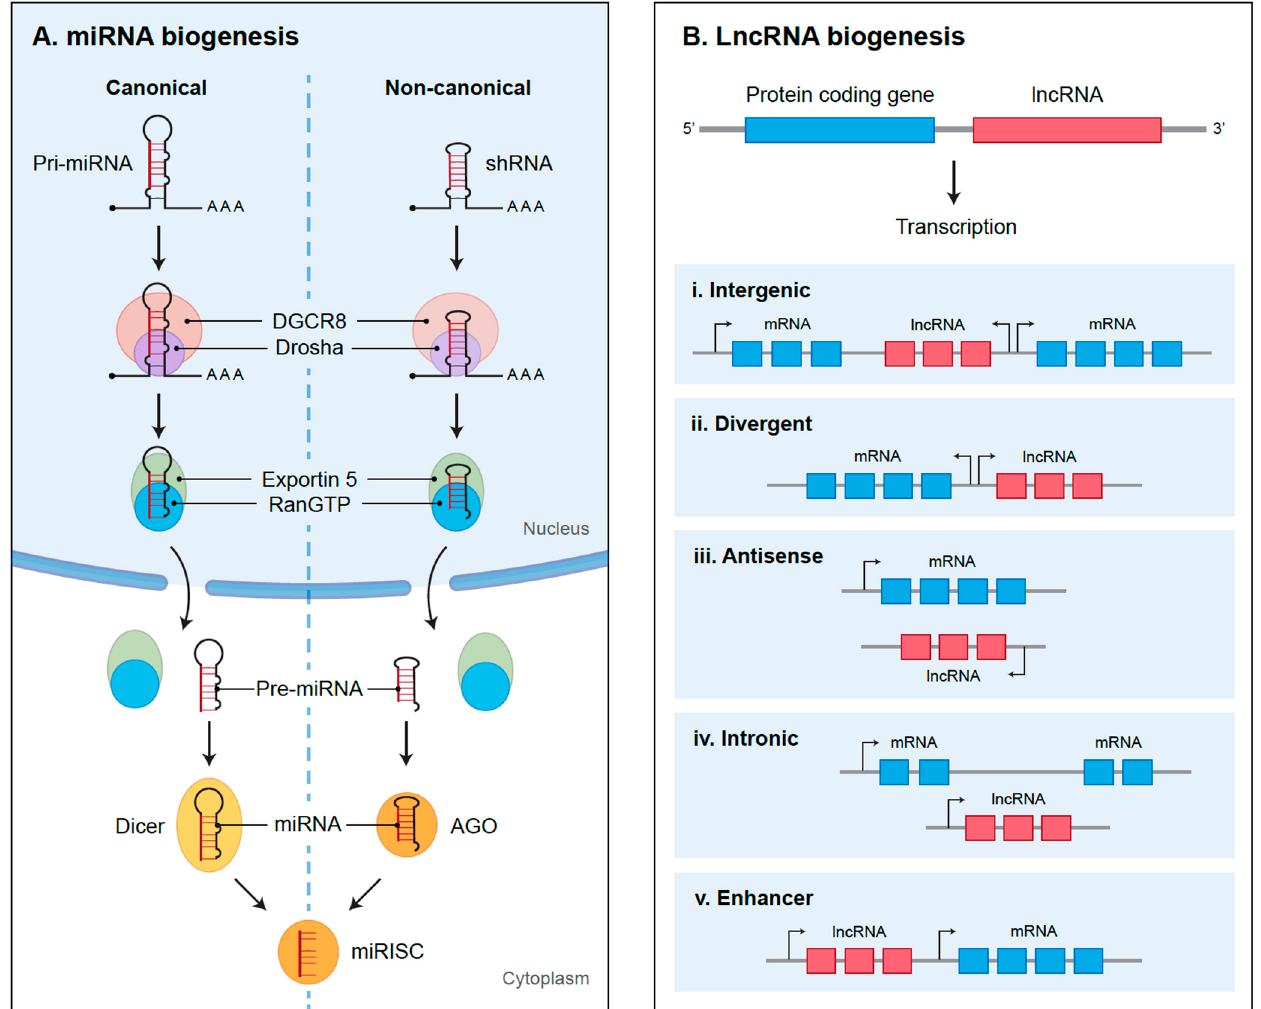
Figure 1. The biogenesis of noncoding RNAs. ( A ) The biogenesis of microRNAs (miRNAs) can occur through either the dominant canonical pathway or the non-canonical pathway. In the canonical pathway, piwi-interacting RNAs (pri-miRNAs) are cleaved by the microprocessor complex, composed of DGCR8 and Drosha, into hairpin structures called the pre-miRNA. The pre-miRNA is exported by the Exportin5/RanGTP complex to the cytoplasm, where it is further cleaved by Dicer into ~22 long nucleotide mature miRNA duplexes. In contrast, the short hairpin RNA (shRNA) transcripts use the Dicer-independent pathway. Here, they are initially cleaved by the microprocessor and exported to the cytoplasm via the Exportin5/RanGTP complex and further cleaved by the Argonaute (AGO) to produce a mature miRNA. Regardless of whether an miRNA is generated through a canonical or non-canonical process, all pathways ultimately lead to a functional miRNA-induced silencing complex (miRISC) that is composed of a guide strand and AGO. ( B ) Long noncoding RNAs (LncRNAs) are transcribed from their respective locations on the genome and are often defined by their location relative to the neighbouring protein-coding genes. Intergenic lncRNAs are transcribed from loci in between two protein-coding genes, whereas intronic are transcribed from inside of an intron of a protein-coding gene. The bidirectional lncRNAs are products of divergent transcription from the promoter of a protein-coding gene. Antisense lncRNAs, on the other hand, initiate inside of a 3’ end of a protein-coding gene and transcribed in the opposite direction.